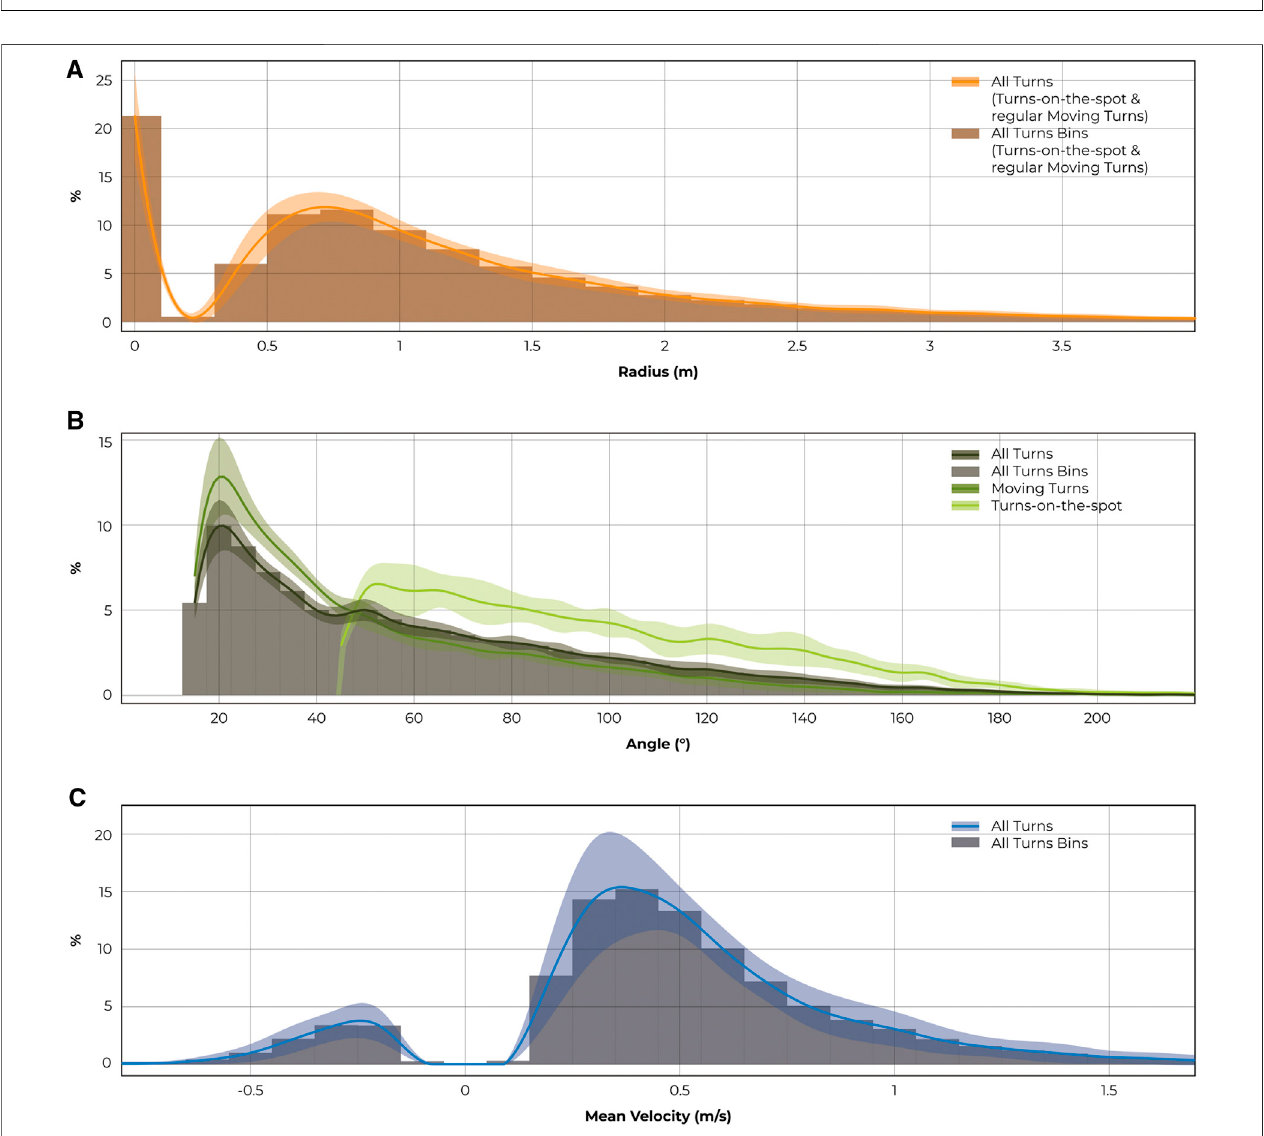
FIGURE 4 | Distributions of (A) turning radii, (B) turning angles and (C) mean velocities of turns are shown. Shaded areas indicate the respective standard deviations. Histograms are given to represent the respective sizes of analysis bins of 0.2 m, 5 ° , and 0.1 m/s.